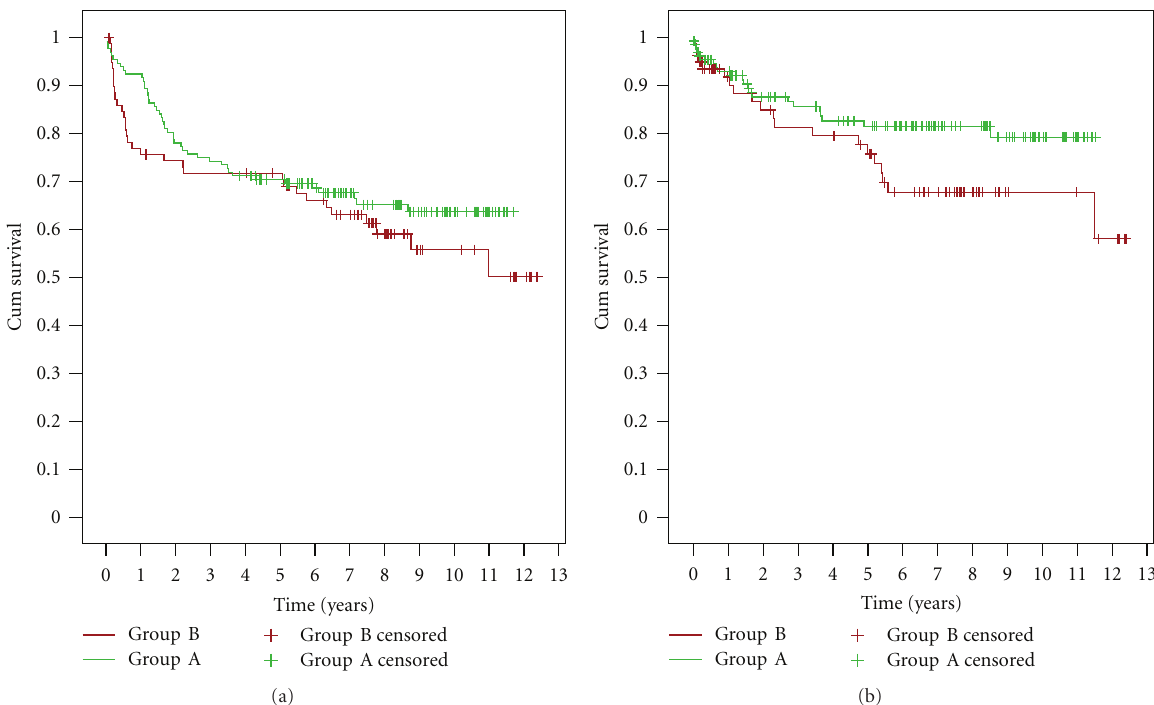
Figure 2: (a) Kaplan curve for patient survival functions. (b) Kaplan curve for graft survival